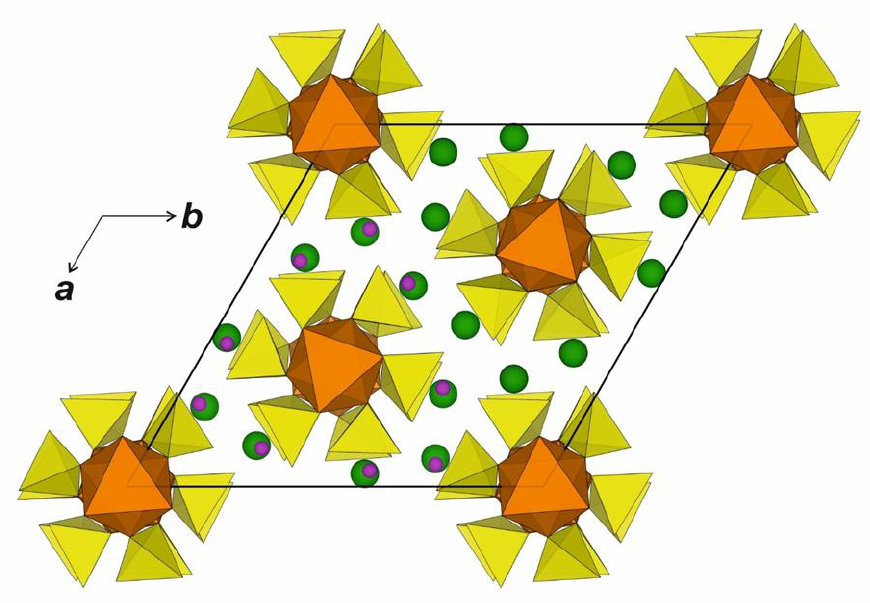
Figure 5. The crystal structure of (K,Na) 3 Na 3 (Fe,Al) 2 (SO 4 ) 6 : projection onto the (001) plane. SO 4 tetrahedra are yellow, FeO 6 octahedra are brown, K and Na atoms are green and purple circles, respectively.